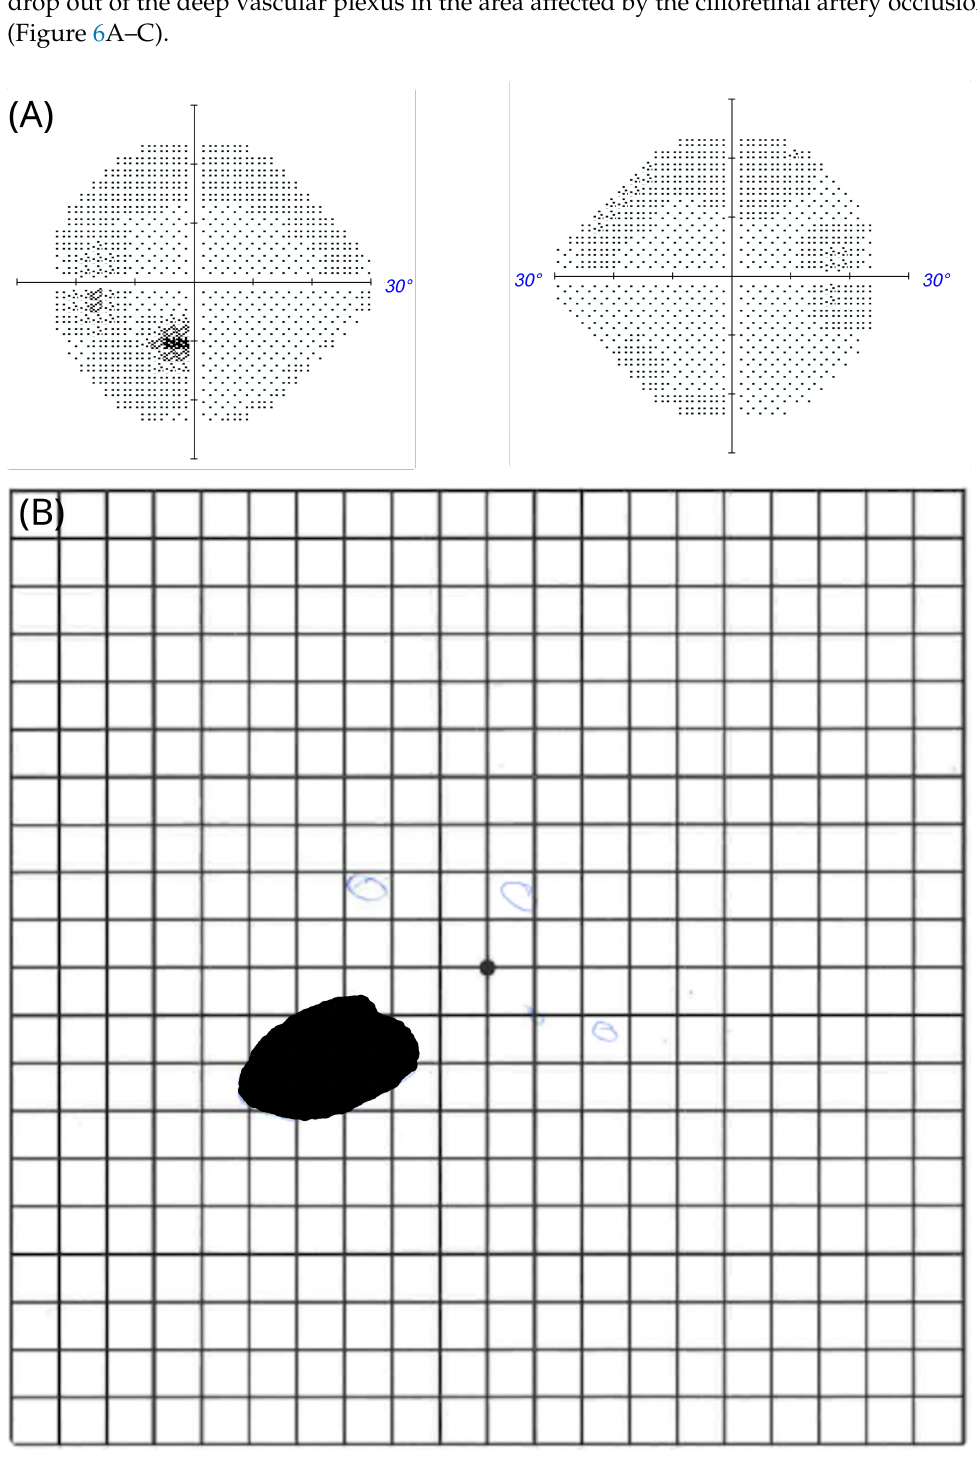
Figure 4. Negative scotoma in patient #2 ( A ) Automated perimetry; ( B ) macular arcuate scotoma on the Amsler